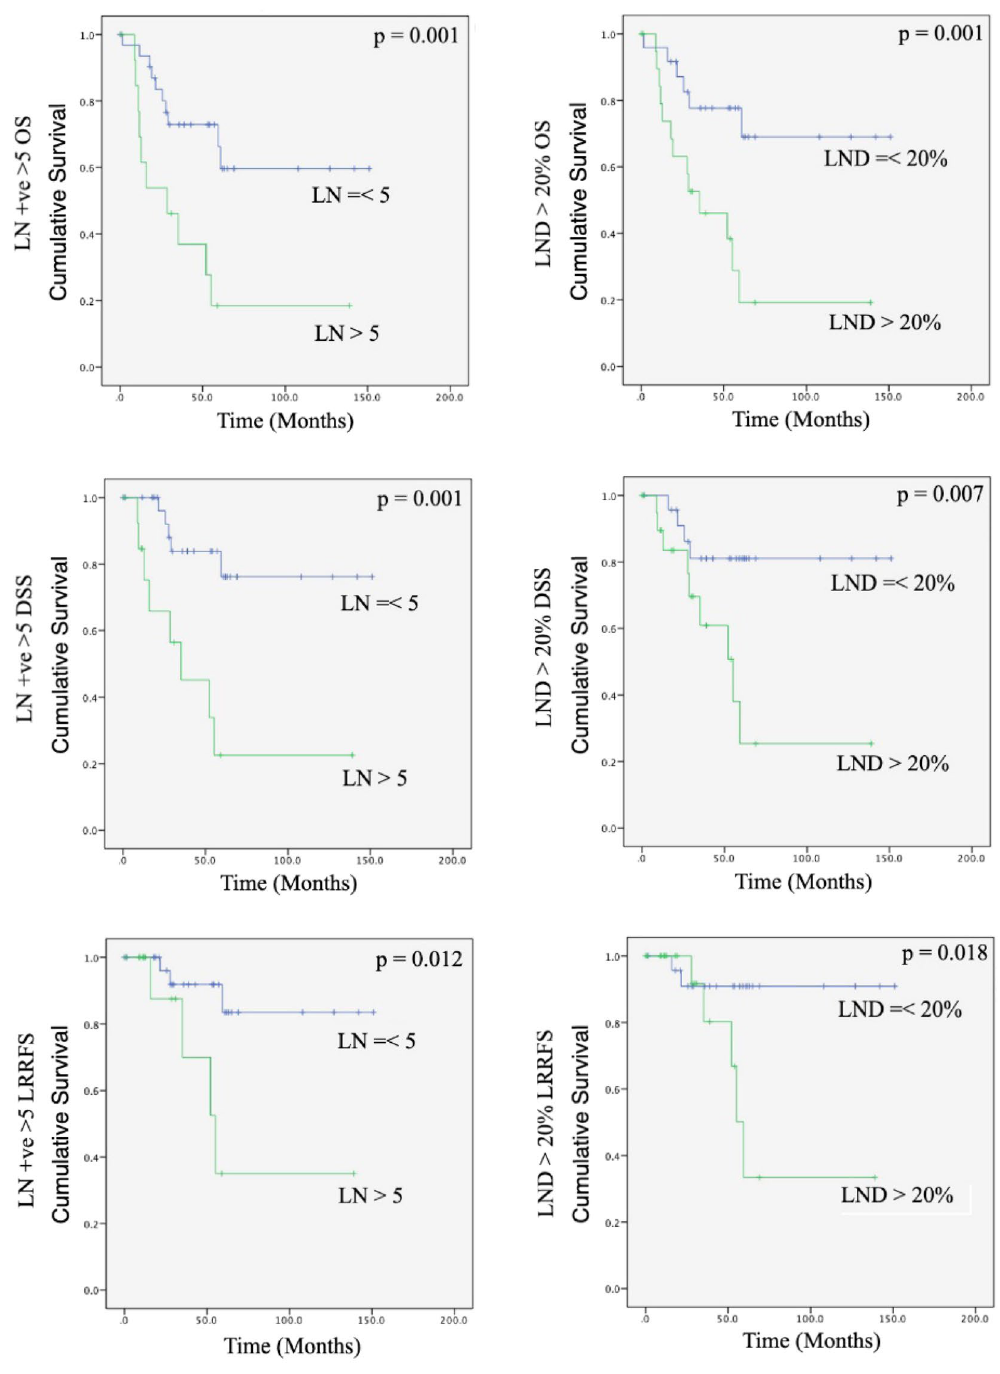
Figure 1. Kaplan Meier survival curves for number of positive lymph nodes more than five and lymph node density more than twenty percent. Notes: OS = overall survival; DSS = disease specific survival; LRRFS = locoregional recurrence free survival. LN + ve > 5: Number of positive lymph nodes more than five; LND > 20%: lymph node density more than twenty